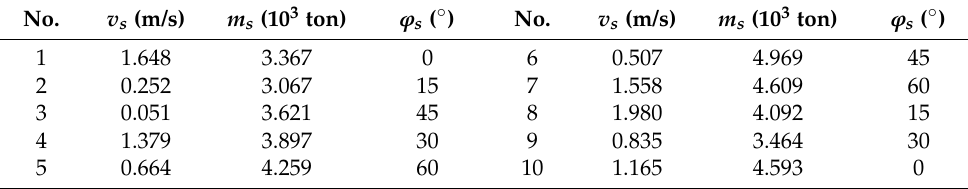
Table 3. 10 groups of collision scenarios for testing selected via LHS